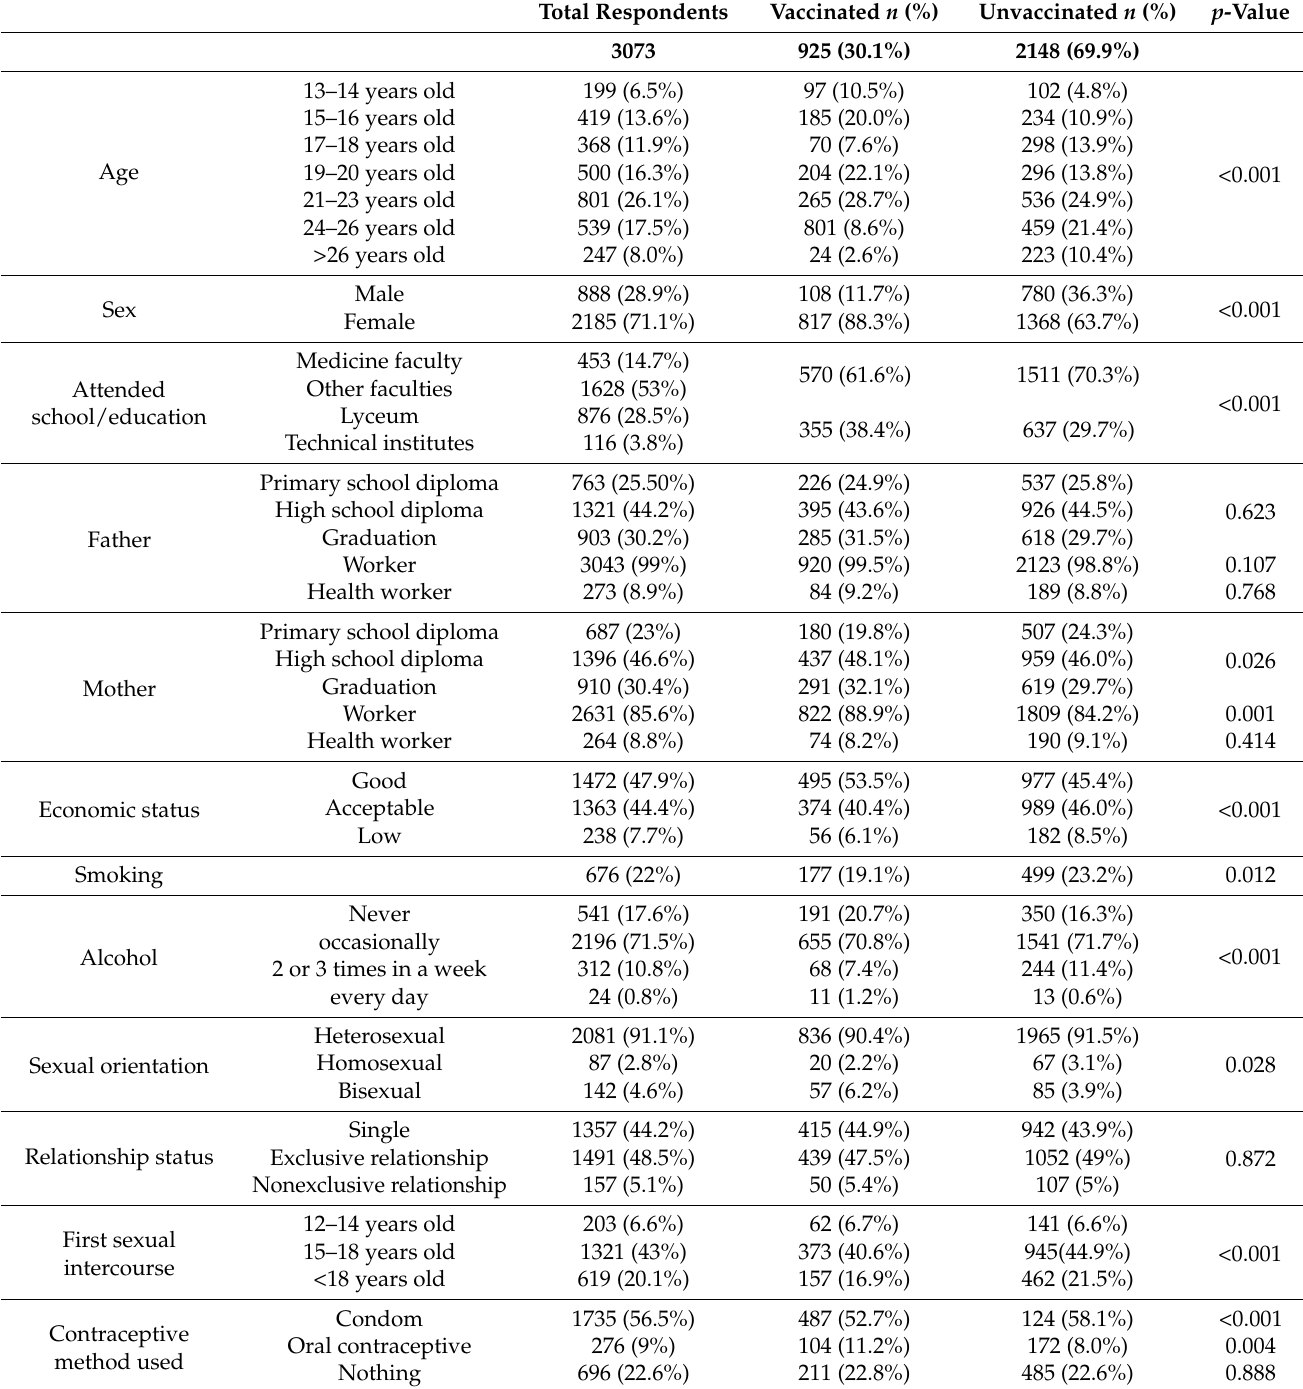
Table 1. Socio-demographic and behavioral characteristic of enrolled students and differences between fully or not vaccinated for